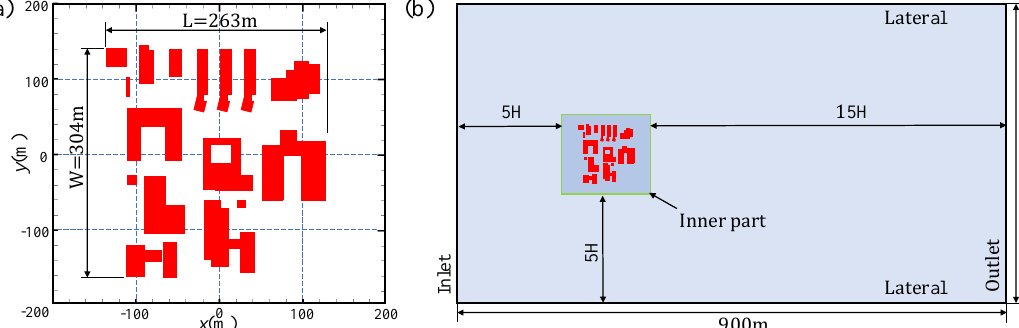
Figure 2. Sketches of ( a ) Model layout and ( b ) computational domain.